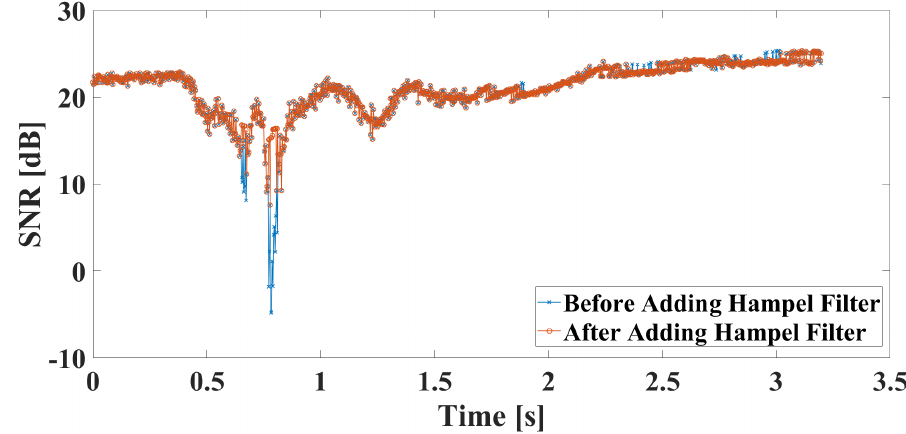
Figure 8. The effect of using the Hampel